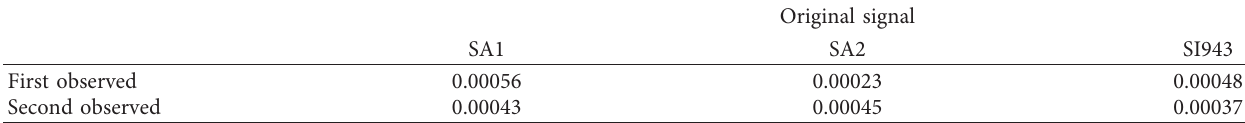
Table 3: Similarity coefficient of source speech signal and observed signal.